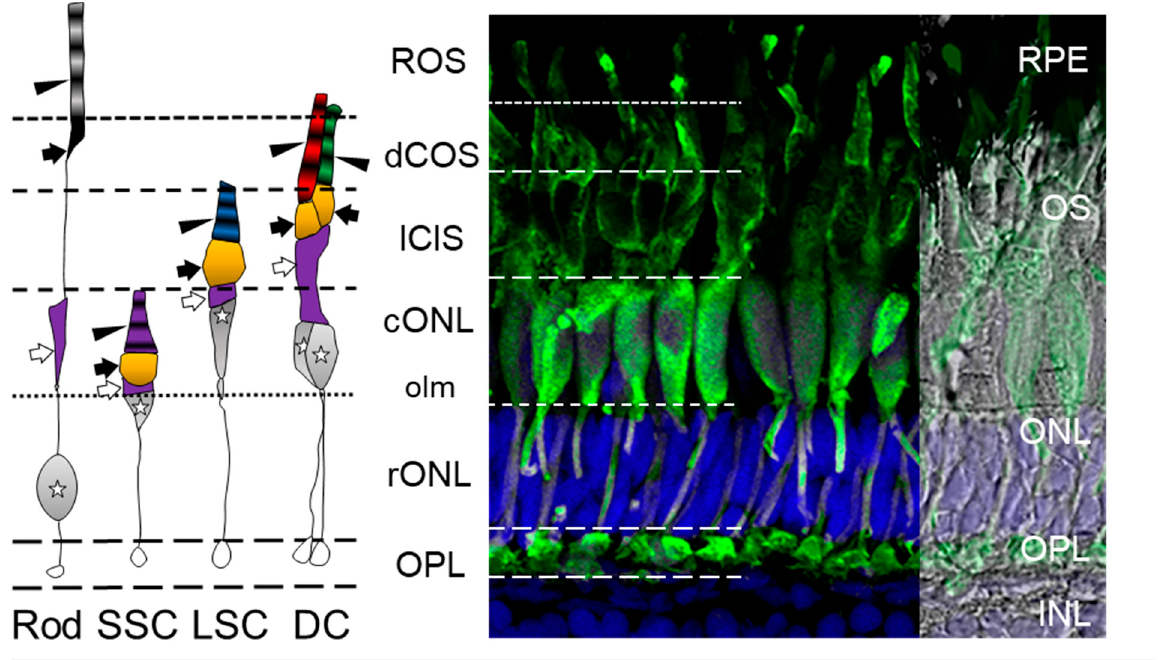
Figure 2. Types of photoreceptors in the zebrafish retina. Illustration showing the different types of photoreceptors in the zebrafish outer retina, along with the location of their outer segment (black arrowhead), ellipsoid (black arrow), myoid (white arrow), nuclei (star), and terminals in the OPL. Confocal image shows anti-Zpr1 (green) labelling of DC photoreceptors and nuclei (blue) in the zebrafish retina. Abbreviations: SSC, short single cones (SSC); LSC, long single cones; DC, double cones; ROS, rod outer segments; dCOS, double cone outer segments; LCIS, long cone inner segment sublayer; cONL, cone outer nuclear layer; olm, outer limiting membrane; rONL rod outer nuclear layer; OPL, outer plexiform layer, RPE, retinal pigment epithelium; OS, outer segment; ONL, outer nuclear layer; INL, inner nuclear layer. Figure adapted from [64] .